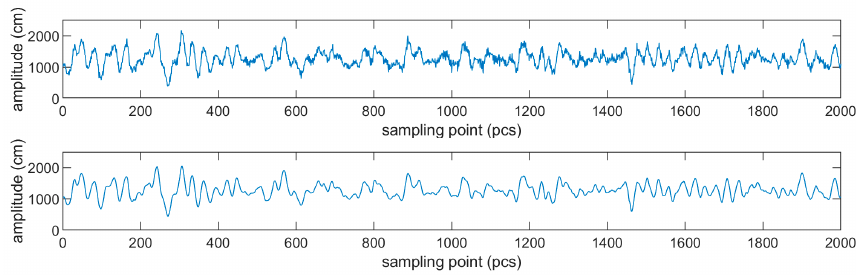
Figure 11. Variation law of different entropies for the actual micro-seismic data. ( a ) ApEn; ( b ) SampEn; ( c ) FE; ( d ) PE.